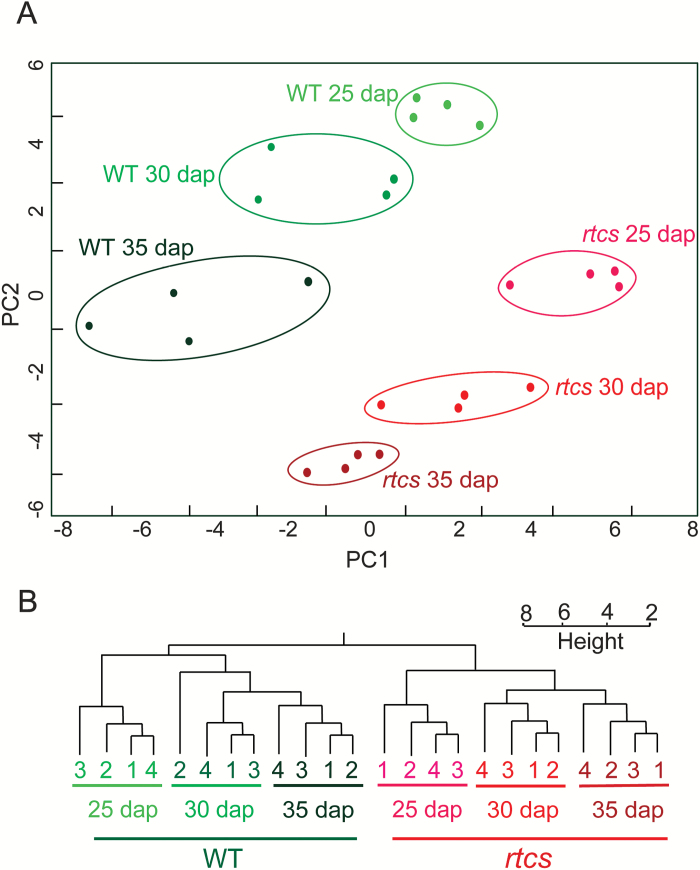
Transcriptome relationships of wild-type and rtcs embryos. (A) Principal component analysis (PCA) of wild-type and rtcs embryo RNA-Seq samples during development. (B) Hierarchical clustering of the RNA-Seq samples based on Pearson correlation. Height indicates the degree of variance of the y-axis.